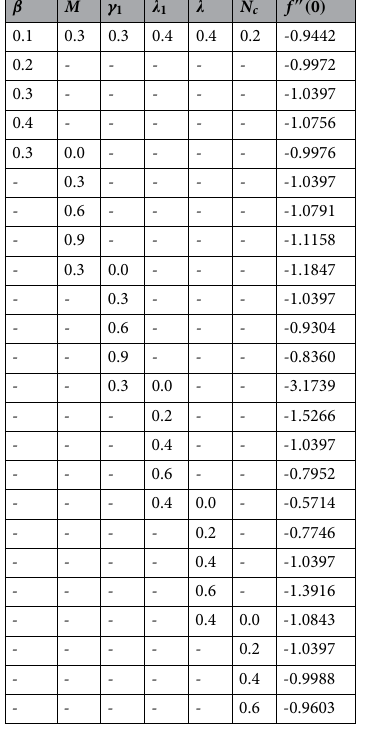
Table 1. Numerical results of f ′′ ( 0 ) for different values of physical